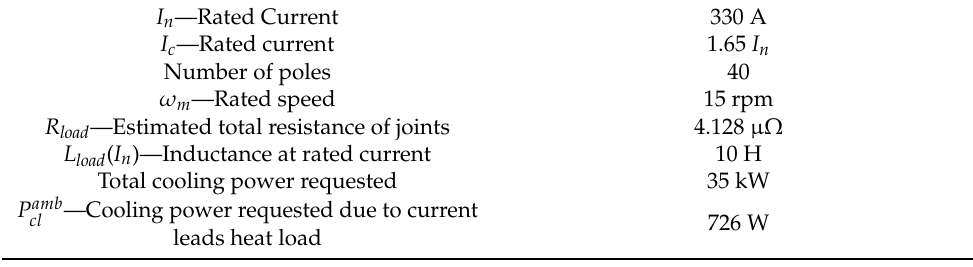
Table 1. HTS field winding specifications.